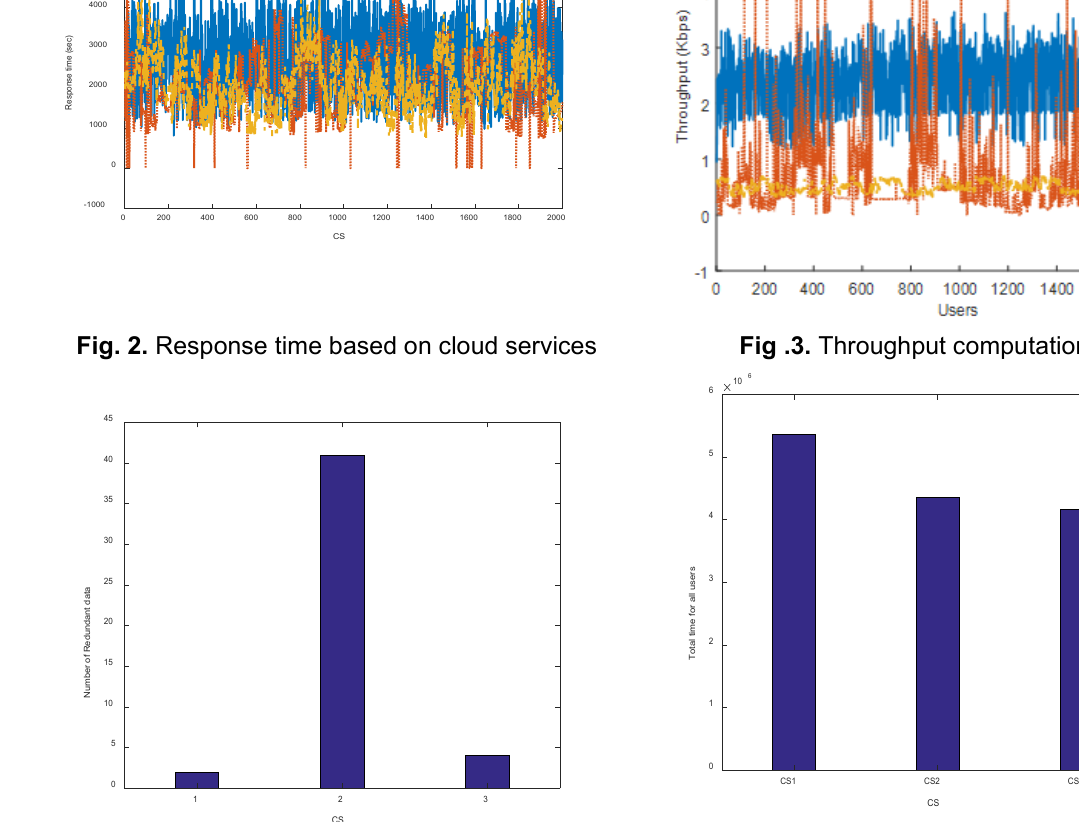
Fig. 4. Number of redundant data from incoming task